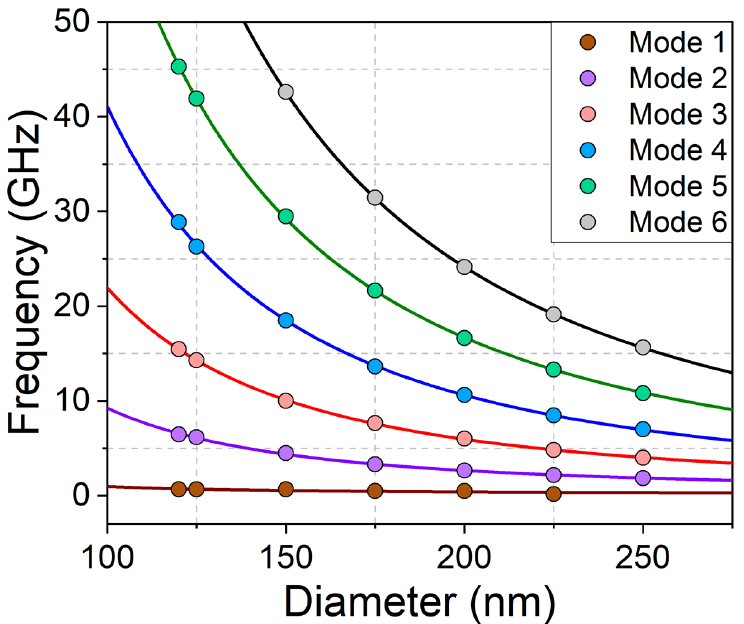
Figure 7. Eigenfrequencies variations with dot diameter. The calculation parameters are: dot thickness = 1.4 nm, M = 1220 emu/cm 3 , K = − 1.04 erg/cm 3 , D = − 1.34 erg/cm 2 , A = 1.6 µ